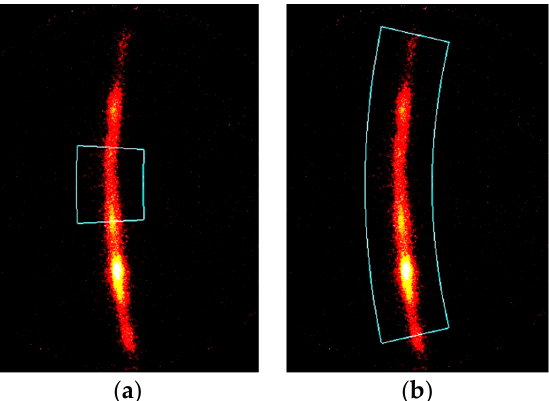
Figure 8. Typical X-ray diffraction pattern detected by 2D-PSPC from stainless steel treated using cavitation peening (Specimen A) and the analyzed area ( d col = 0.146 mm, ψ = 0°, φ = 0 °, ∆ ω = 0°, t exp = 20 min, x = 0 mm, y = 0 mm); ( a ) analyzed area for the sin 2 ψ method (2 θ = 125–132°, χ =